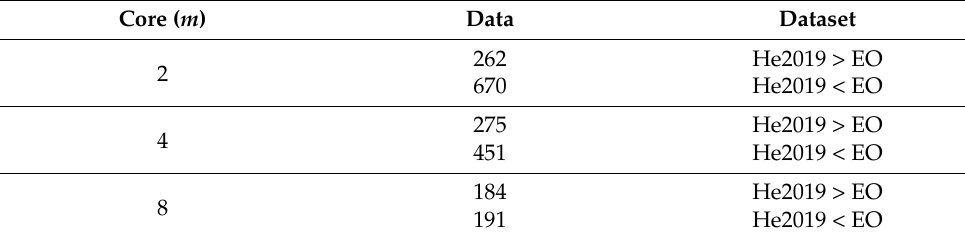
Table 2. The joint-level priority allocation realized in ( α , β